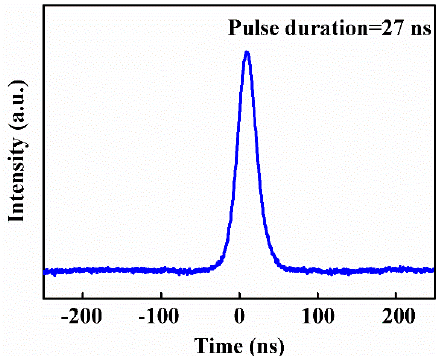
Figure 5. Typical pulse profile recorded at 0.26 kHz pulse repetition frequency (PRF) under 10 W of absorbed pump power.